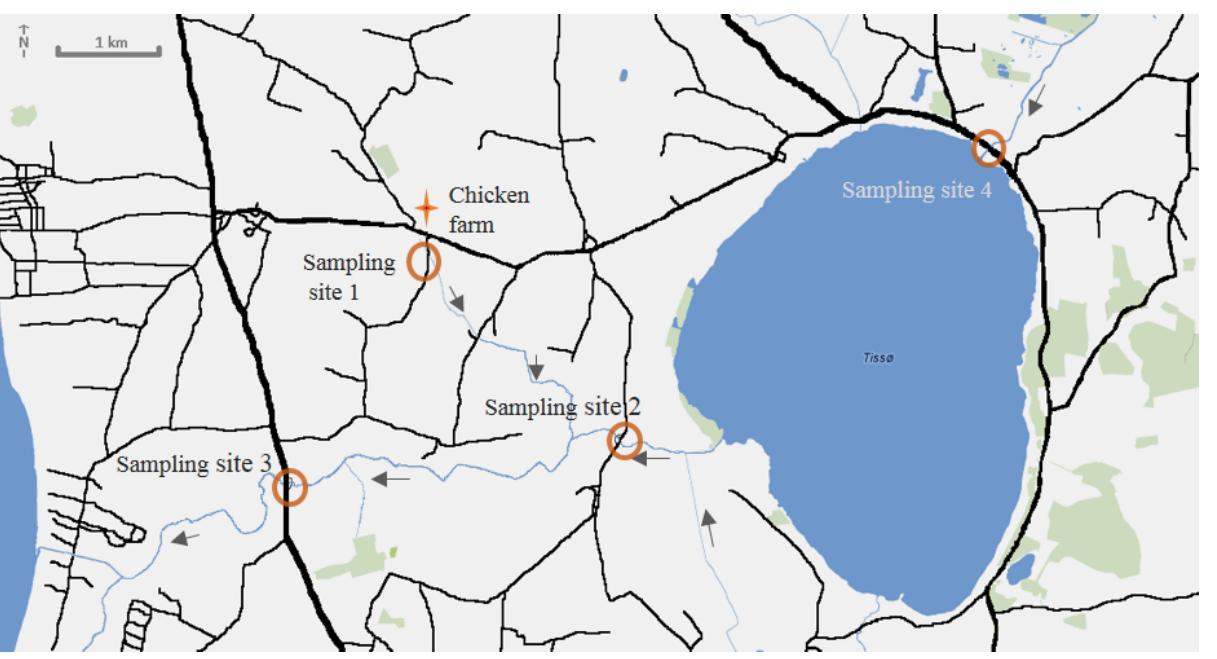
Figure 2. Four sampling sites down- and up-stream of the lake Tissø in an agricultural area of Zealand,